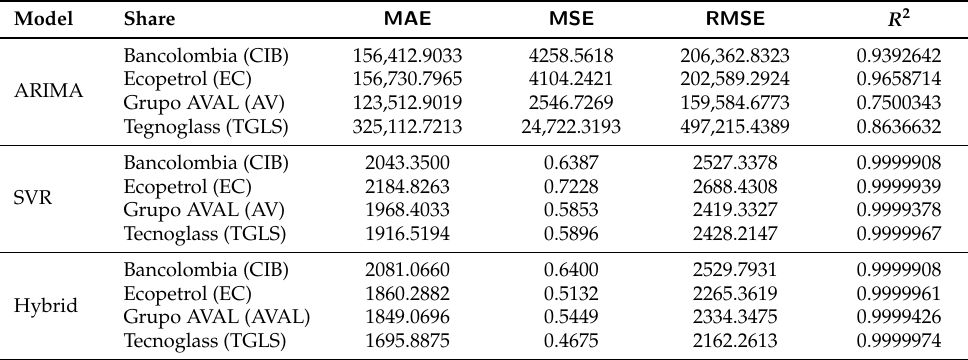
Table 8. Accuracy metrics and R 2 for cumulative returns an all models. The figures in the MAE , MSE , and RMSE columns are to be multiplied by 10 − 7